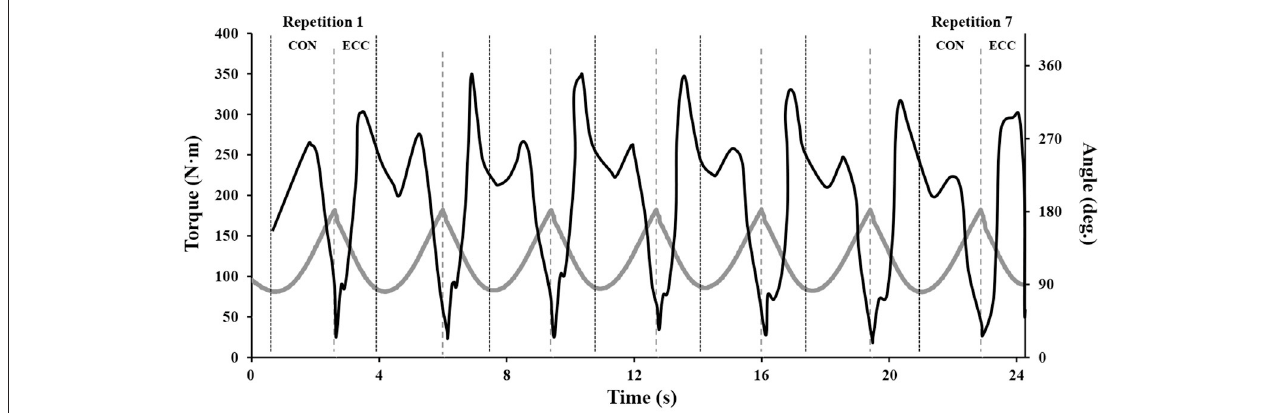
FIGURE 1 | Typical smoothed torque values across a set of 7 maximal repetitions of YoYo TM knee extension exercise in young healthy men. Black line denotes torque; gray line denotes knee angle. Typically, torque increases over the initial three repetitions, whereas from the fourth or fifth repetition, peak torque typically decreases due to